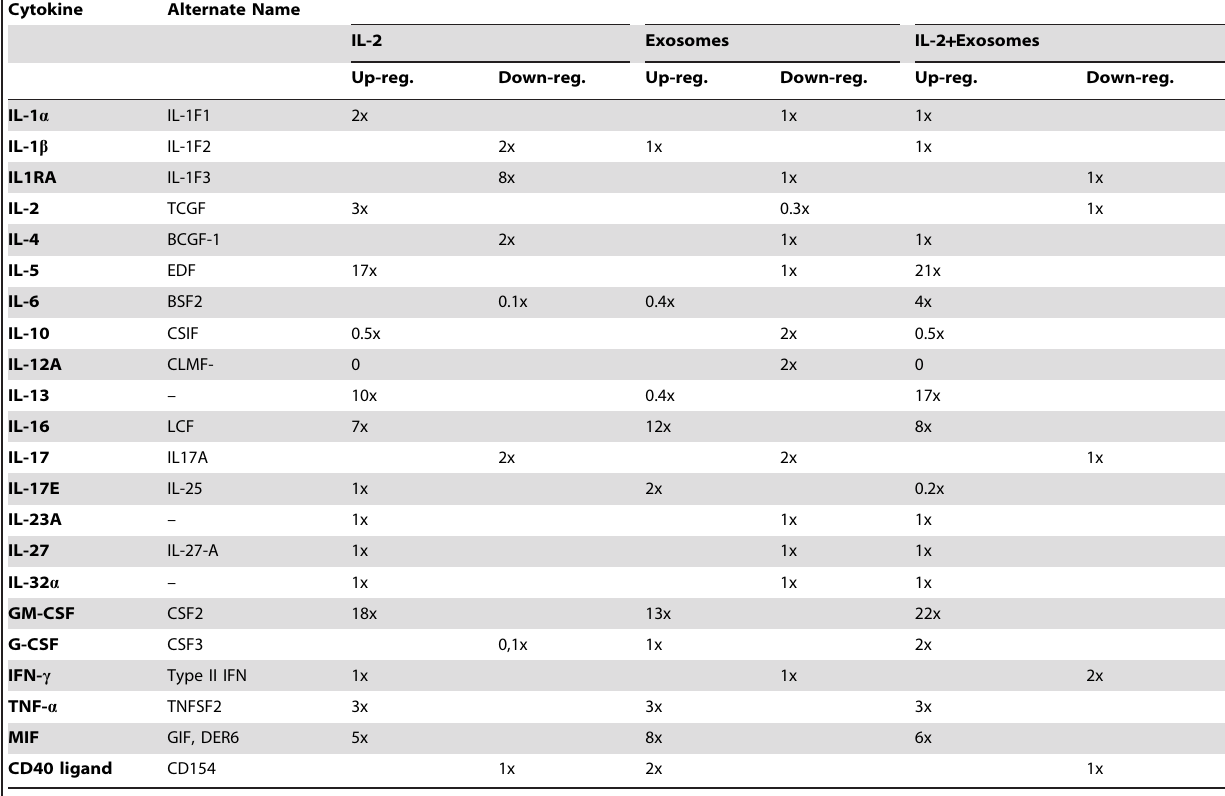
Table 1. Human cytokine array (Cytokines).